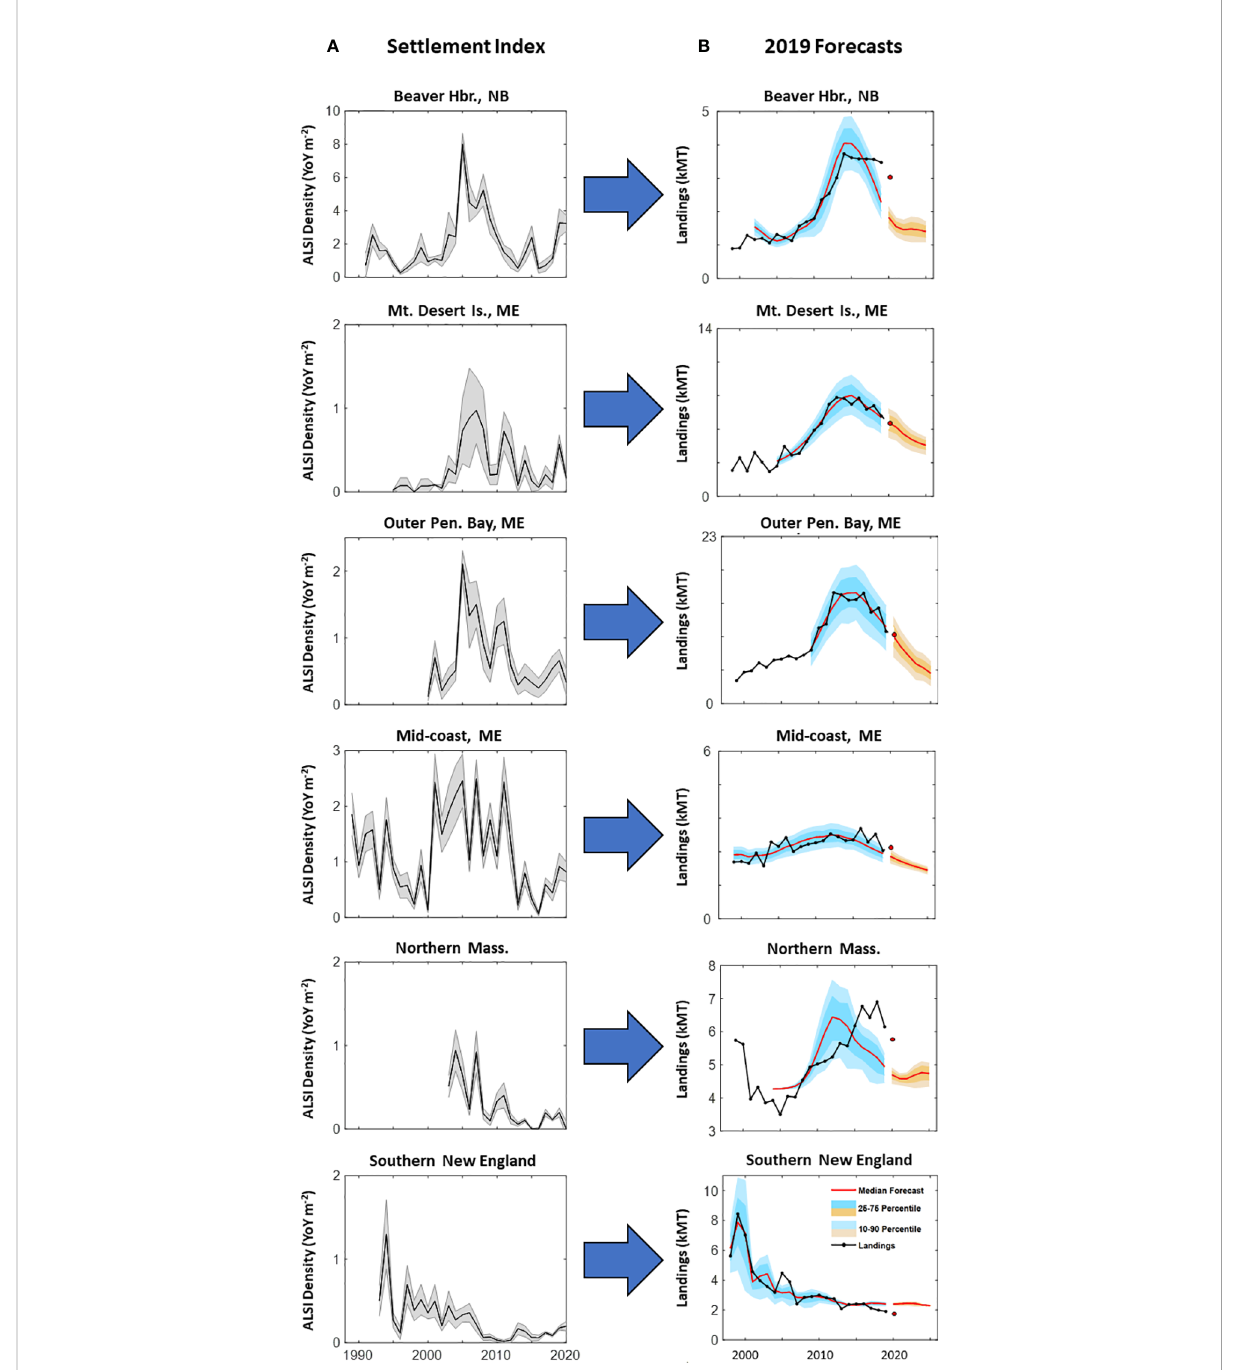
FIGURE 5 Settlement indices by region (A) and their corresponding forecast to landings (B) . Settlement indices include annual means and standard error. Forecasts include the settlement and landings relationship through 2019 (blue segment) and the skill of the forecast (orange) is assessed as landings accumulate. Methods for the forecast model can be found in Oppenheim et al., 2019. The 2020 landings are also presented (red